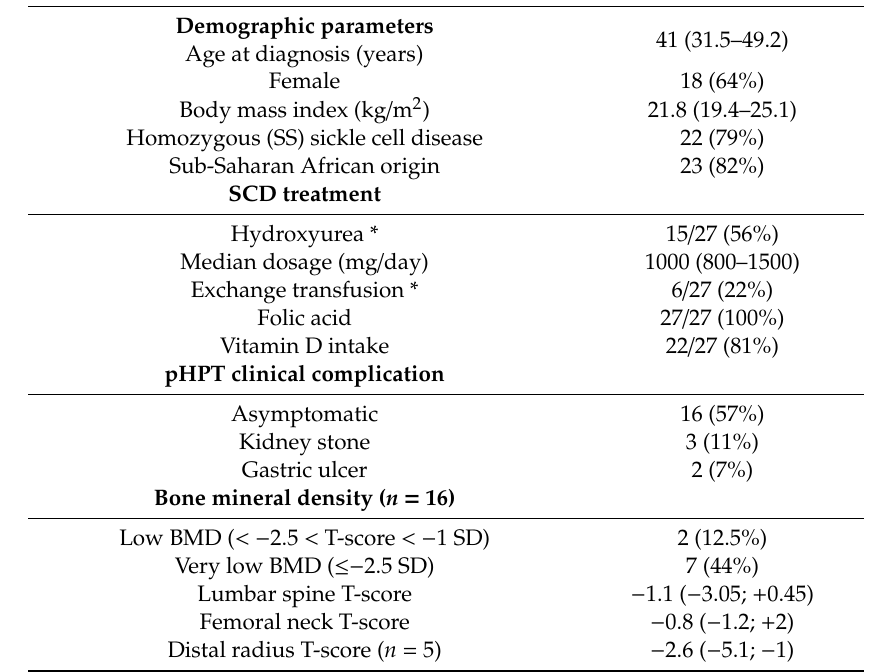
Table 1. Clinical and radiological features of 28 adult patients with primary hyperparathyroidism and sickle cell disease at the time of pHPT